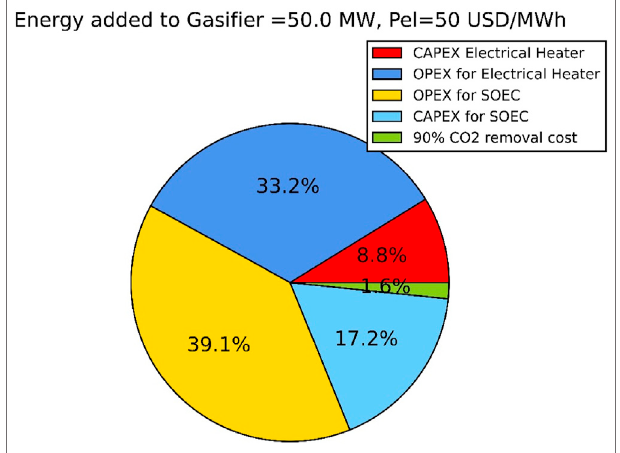
FIGURE 10 | Distribution of costs for the SOEC scenario with Pel (cid:2) 50 USD/MWh.